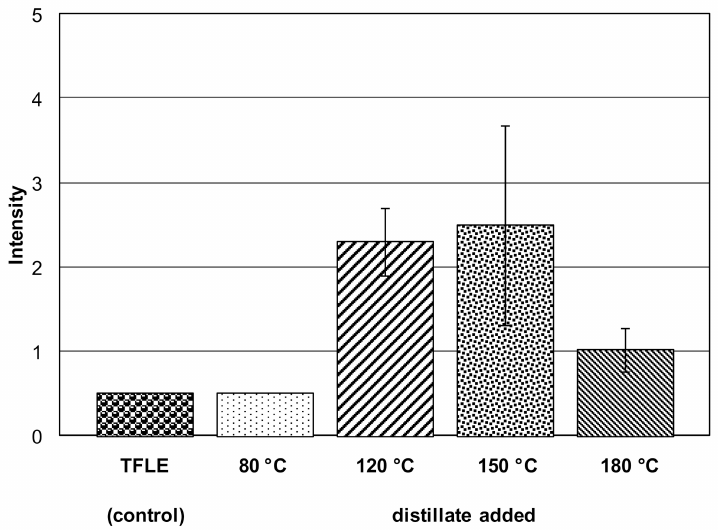
Figure 2. Enhancement of creamy flavor by the semi-volatile isolate obtained by n -pentane extraction at 80/120/150/180 ◦ C. The isolates (natural concentration rations according to 20 g of chocolate per 100 mL TFLE) were suspended in TFLE for sensory